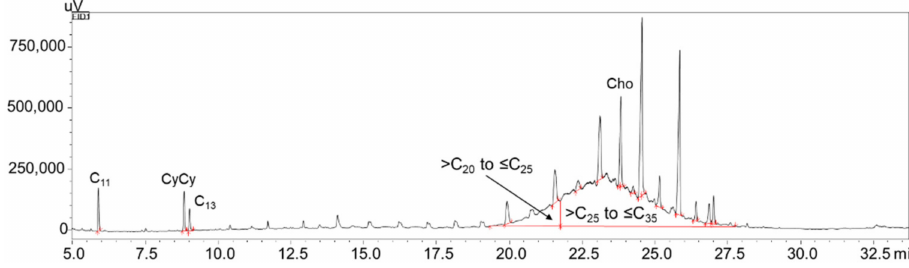
Figure 2. LC–GC expansion of the MOSH fraction of sample 5, along with IS and